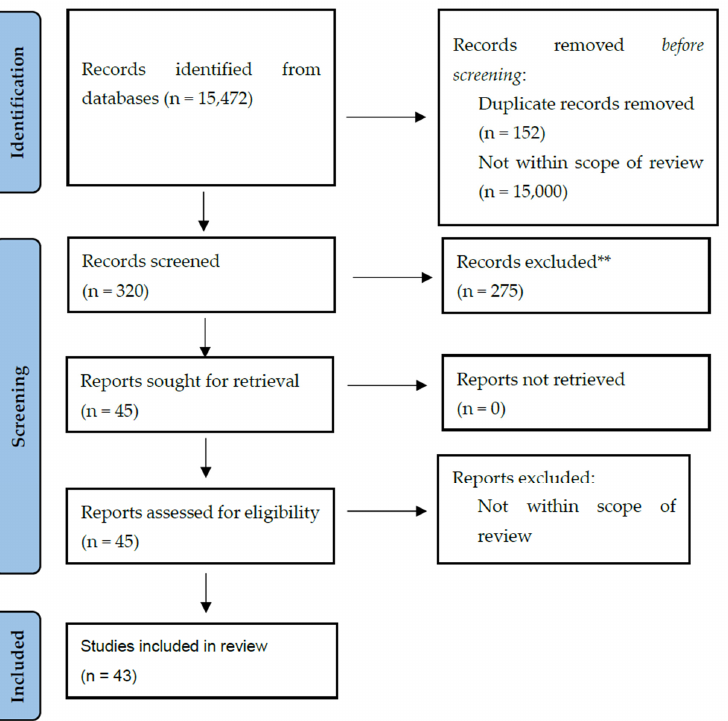
Figure 1. Flowchart of articles retrieved for review using PRISMA framework. Flowchart layout modified from